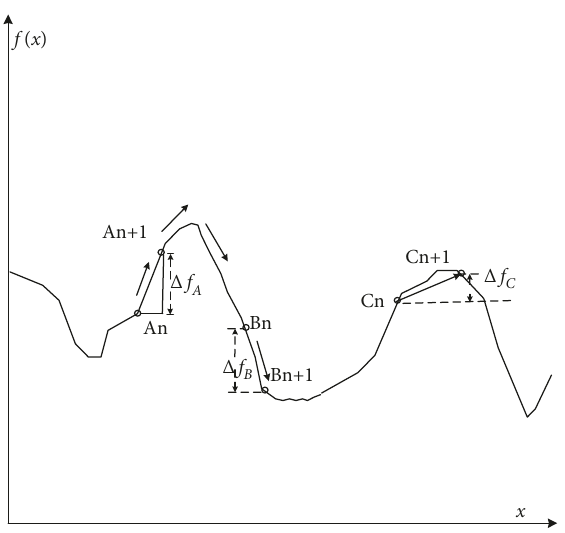
Figure 2: Entropy of function